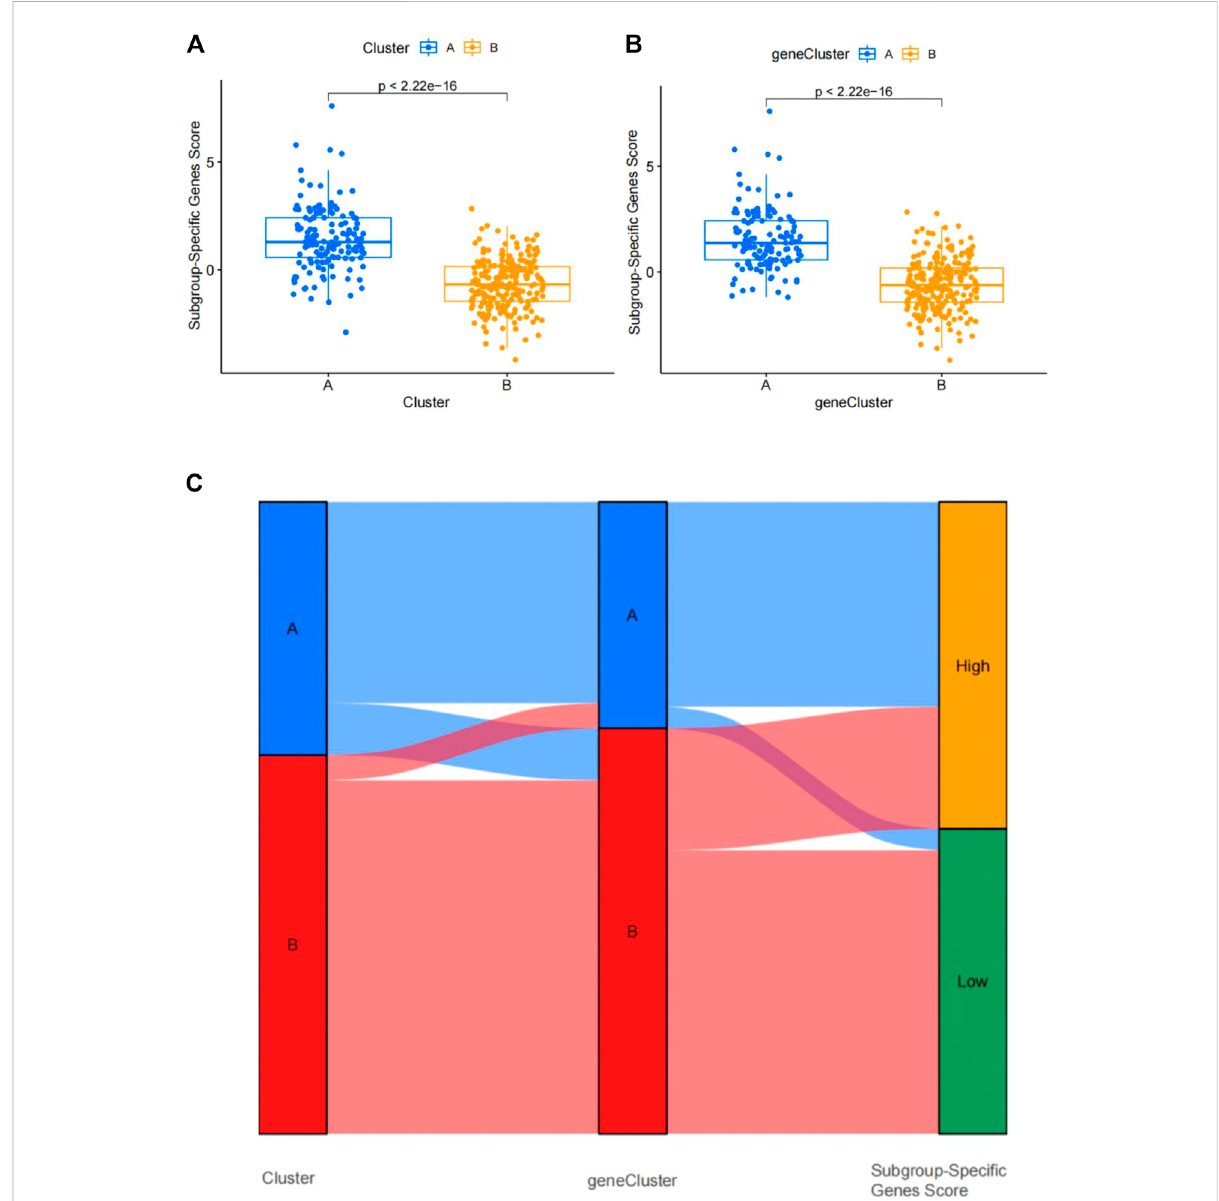
FIGURE 12 Differential analysis of four subgroup-speci fi c gene scores between the two clusters. (A) Differences in four subgroup-speci fi c gene scores between cluster A and cluster B. (B) Differences in four subgroup-speci fi c gene scores between gene cluster A and gene cluster. p < 0.05 indicates signi fi cance. (C) Sankey diagram showing the relationships among clusters A and B, gene clusters A and B, and subgroup-speci fi c